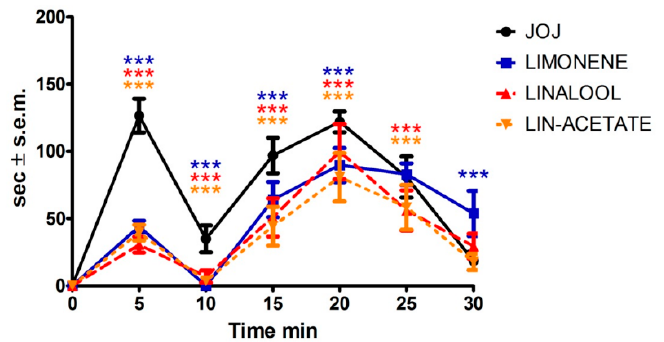
Figure 6. Time course of the analgesic efficacy of D -limonene, linalool, and linalyl acetate on licking/biting behavior in the formalin test. Effect of limonene, linalool, and linalyl acetate on the time course of the licking/biting time monitored at 5 min intervals of and expressed as time in s ± S.E.M reported during the formalin test. Two-way ANOVA followed by Bonferroni test; n = 8; *** p < 0.001.